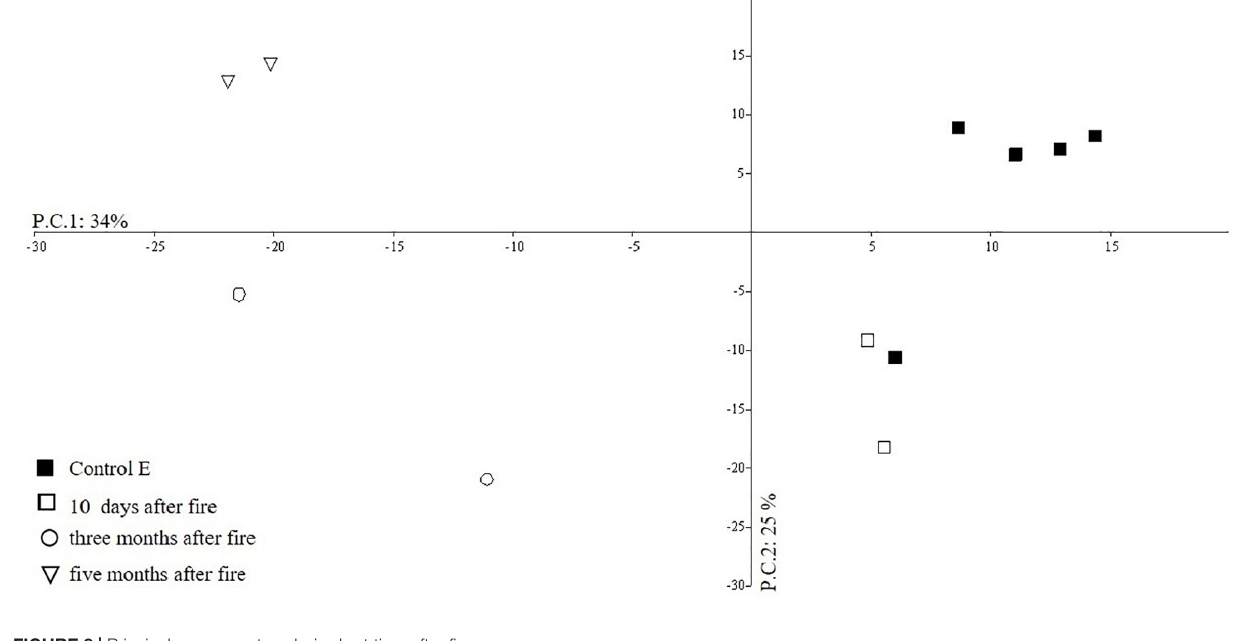
FIGURE 8 | Principal component analysis short time after fire.